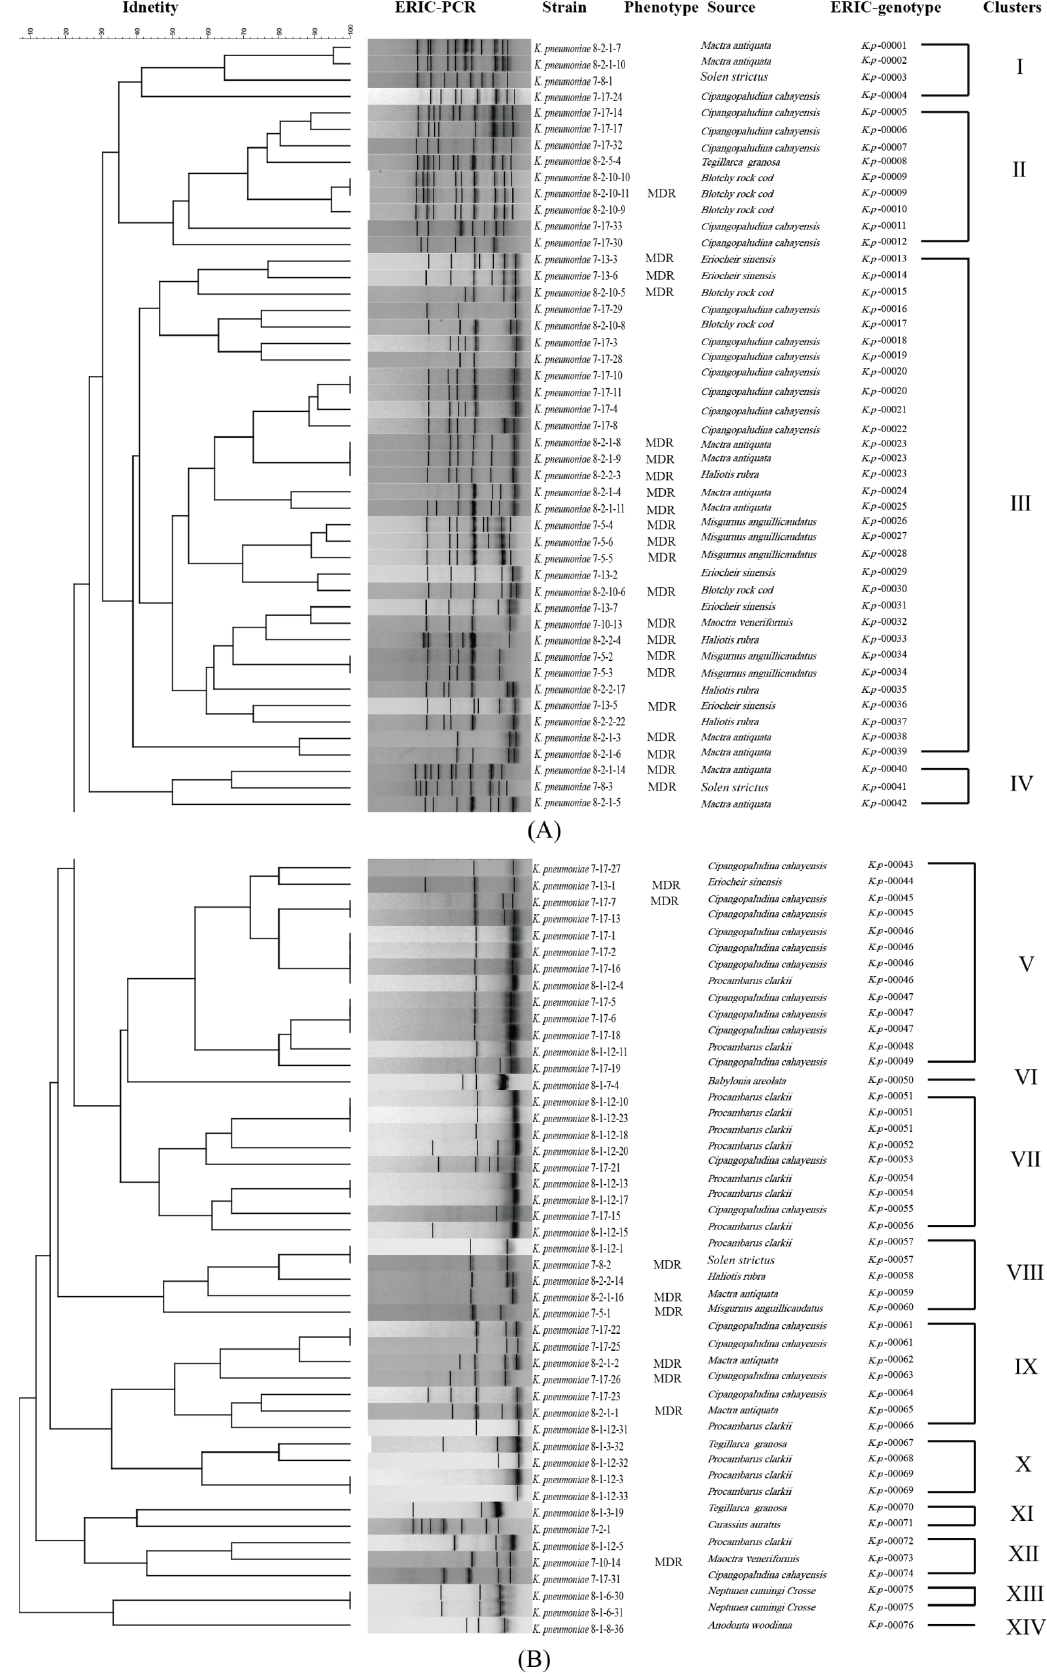
To get insights into the coresistance mechanism between the MDR and heavy metal tolerance, we further investigated the 32 MDR K. pneumoniae strains by using a phyloge- netic analysis. As shown in Figure 3, the MDR strains were grouped into six clusters (Clus- ters A to F), wherein approximately 50.0% (16/32) fell into Cluster B, with 13 ERIC geno- types, followed by Cluster C (12.5%, 4/32) and Cluster F (12.5%, 4/32), with four ERIC genotypes. Remarkably, 84.4% ( n = 27) of the 32 MDR strains were classified as singletons. The K. pneumoniae strains in M. antiquata were classified as more singletons ( n = 8), fol- lowed by E. sinensis ( n = 4) and M. anguillicaudatus ( n = 4). Additionally, the obtained Simp- son’s diversity index was 0.8488. These results provided direct evidence for the abundant genetic diversity of the MDR K. pneumoniae strains.